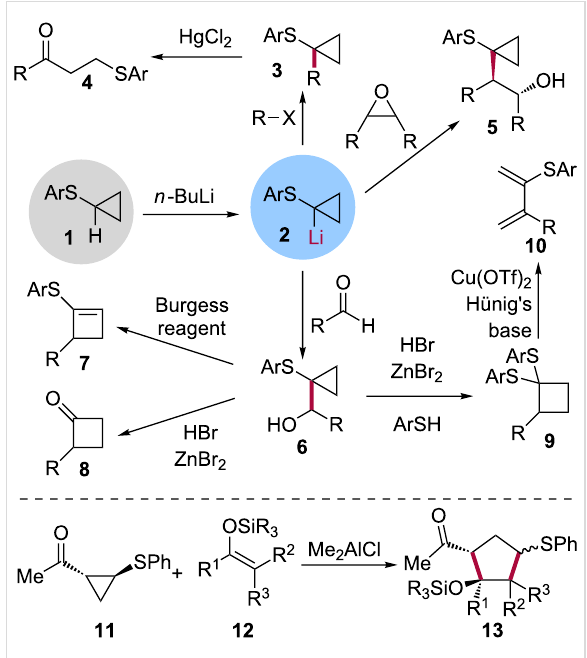
Scheme 1: Synthetic uses of aryl cyclopropyl sulfides 1